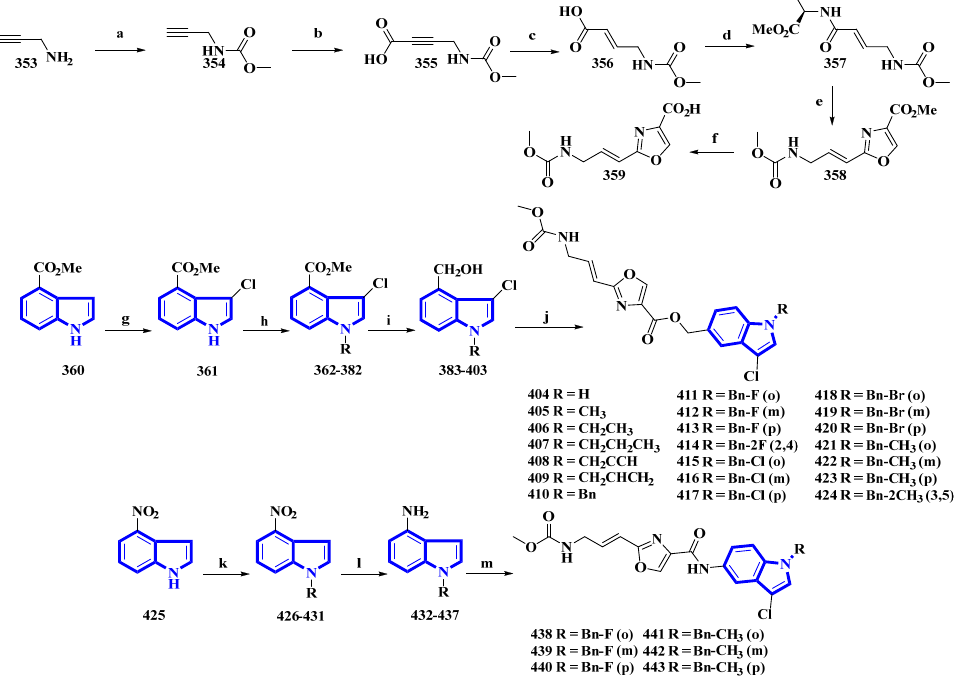
Figure 22. Synthesis of neopeltolide derivatives 404 to 424 and 438 to 443 . (a) NaHCO 3 , 1,4-dioxane, rt, 95%; (b) n -BuLi, CO 2 , THF, − 78 °C, 84%; (c) H 2 , Lindlar’s catalyst, EtOAc, 91%; (d) l-Serine methyl ester hydrochloride, i-BuOCOCl, N -CH 3 -morpholine, THF, 75%; (e) (1) DAST, DCM, − 78 °C and (2) BrCCl3, DBU, − 20 °C, 62%; (f) LiOH, THF/H 2 O, 88%; (g) NCS, HCl, THF, 82%; (h) Substituted benzyl chlorides, NaH, DMF, rt, quantitative; (i) DIBAL-H, THF, − 78 ◦ C, 57–75%; (j) 359 , EDCI,